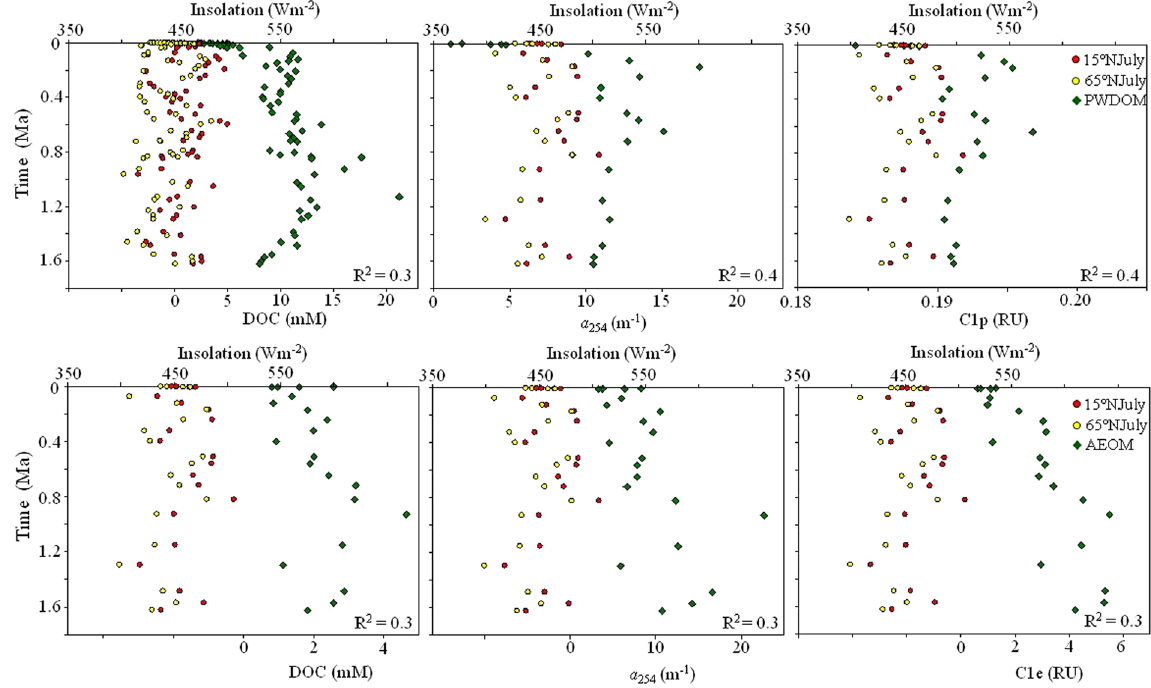
Figure 5. Co-variation of the insolation at 15°N and 65°N in July with PWDOM (upper row) and AEOM (lower row) parameters in a ~405-Kyr cycles at site U1 ( p < 0.05). Linear correlation excluding the depth above the SMTZ and below 118 mbsf. Insolation and age model based on literature 1, 31